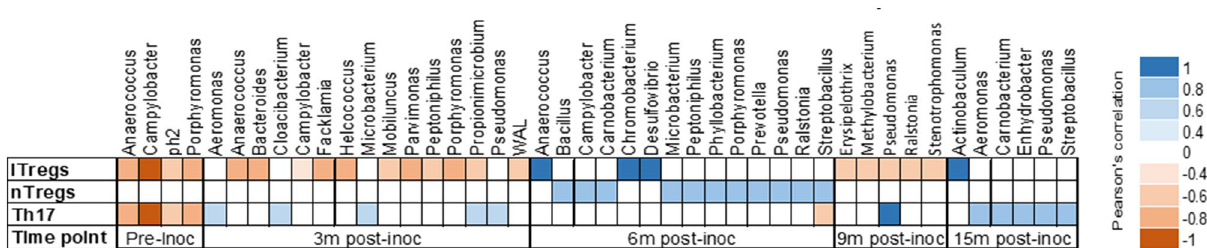
Figure 8. Pearson’s correlation coefficient of urinary bacterial communities with level of peripheral immune cell populations (iTregs, nTregs, Th17) in 8 non-human primates from pre- and post-inoculation of